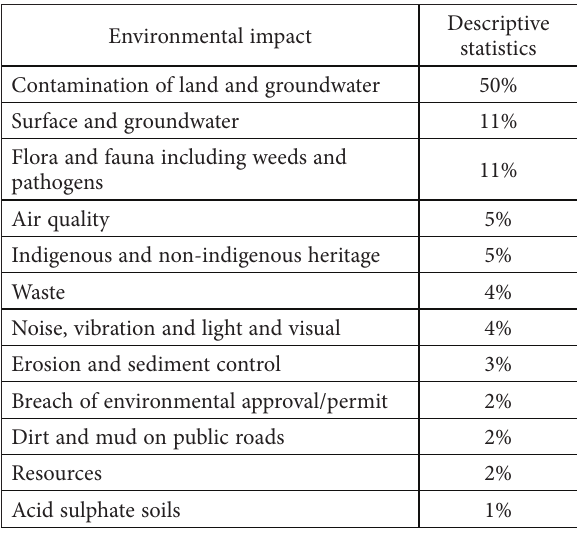
Table 4. Environmental impact of